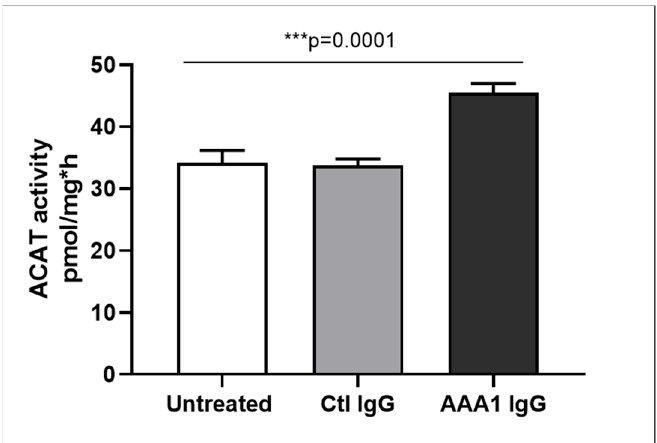
Figure 5. ACAT activity. Cells were incubated for 24 h in RPMI medium with 10% FCS, control IgG or anti-apoA-1 IgG 40 μ g/mL. Monolayers underwent a second incubation (4 h) in the presence of [1-14C]-oleic acid albumin complex. Data are expressed as the mean ± SD of the measurements done in triplicate and repeated three times ( n = 3). Statistical differences were determined by one-way analysis of variance (one-way ANOVA), with p ≤ 0.05 being considered significant.